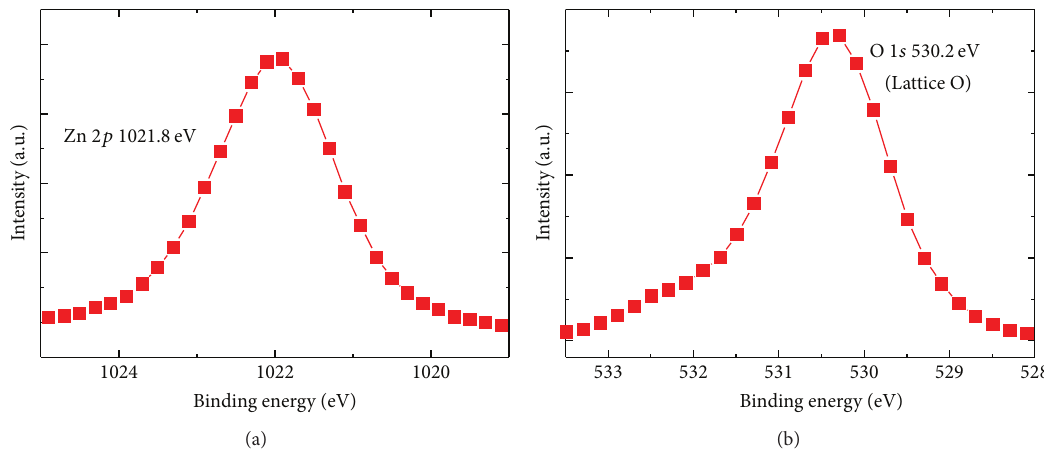
Figure 3: The XPS spectra of (a) Zn 2𝑝 and (b) O 1𝑠 core levels in the ZnO layer by using sputtering. Some nonlattice oxygen ions were observed in the ZnO films.